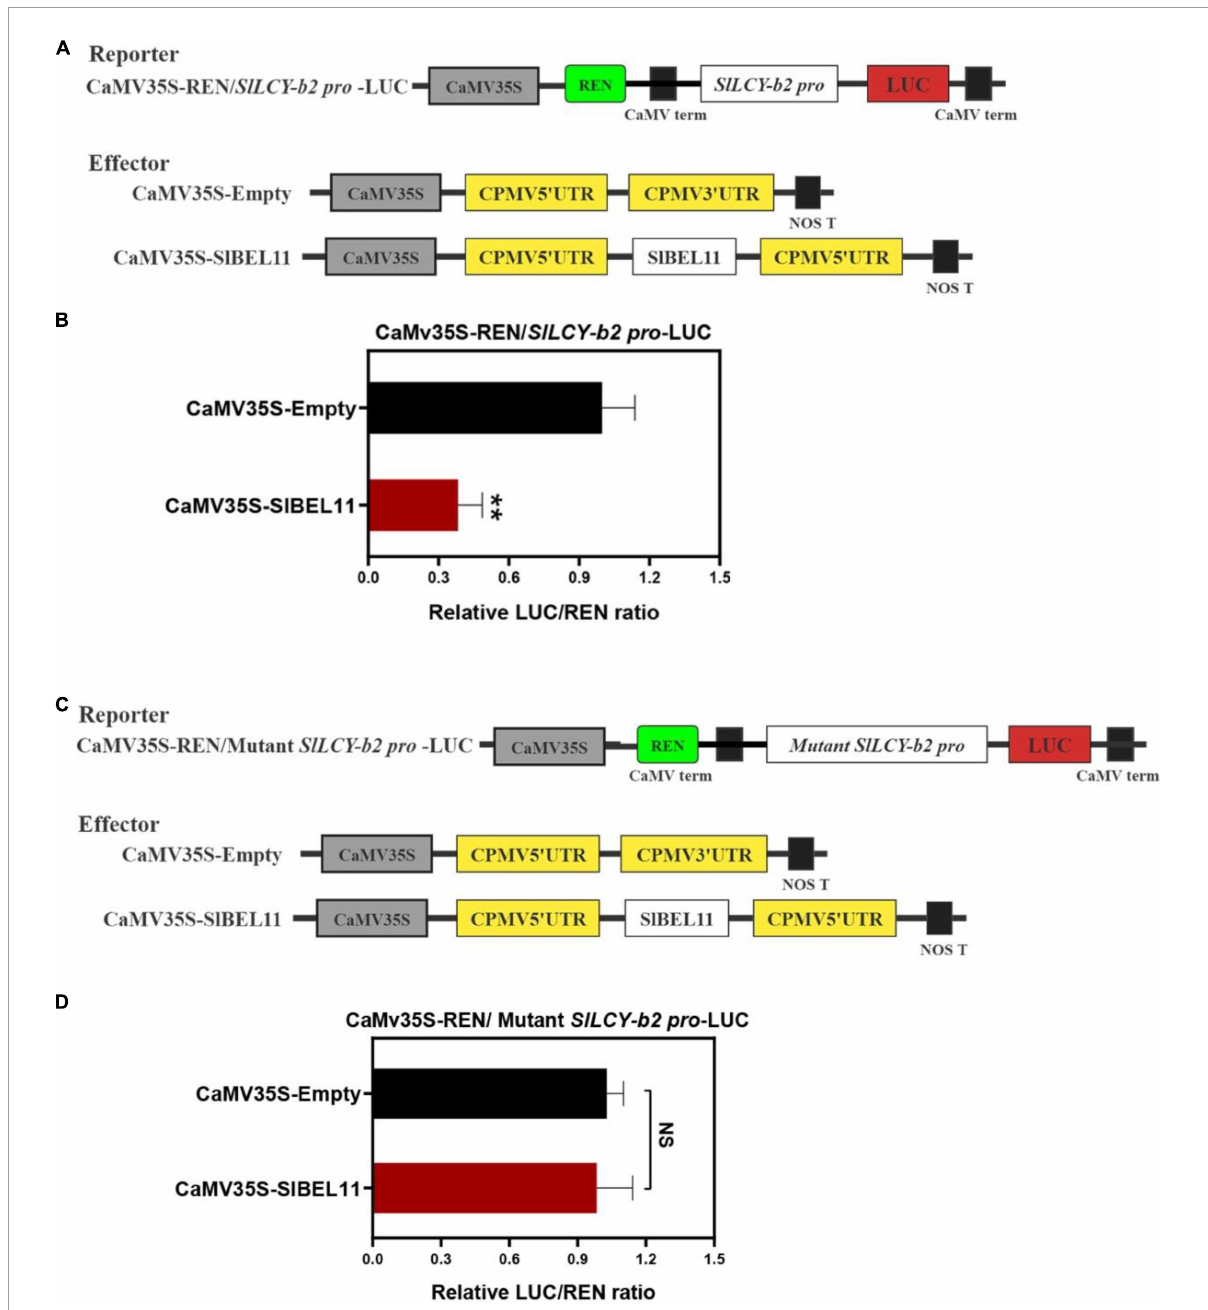
FIGURE4 The dual luciferase reporter assay on SlBEL11 transcriptional repression of SlLCY-b2 . (A,C) , Schematic representation of reporters and effectors vector plasmids. (B) SlBEL11 suppressed the promoter activity of SlLCY-b2. (D) SlBEL11 can not suppress the activity of mutant SlLCY-b2 promoter. Values showed the means of six biological replicates, error bars represented SE. **Indicated that the difference between the values was extremely significant ( P < 0.01) by Student’s t -test. NS, no significant difference.